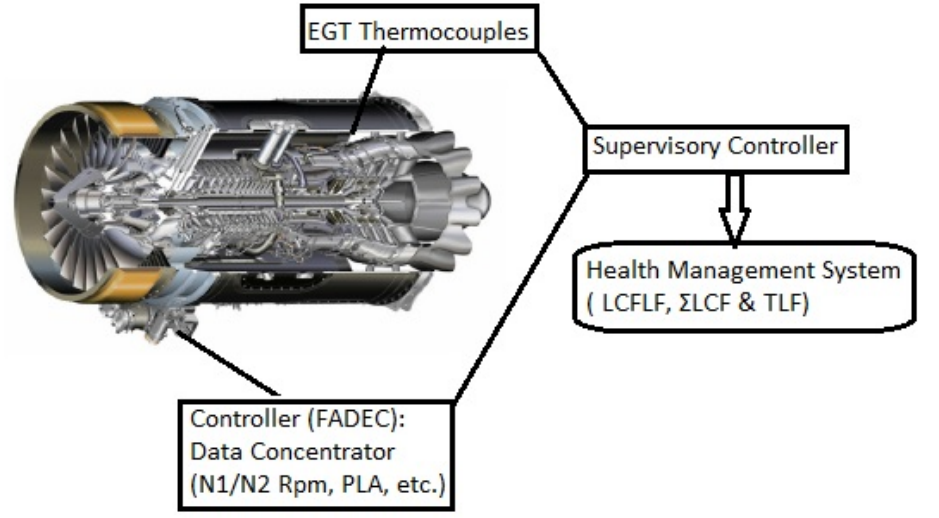
Figure 6. Proposed DEC architecture for EMB 135/145. The picture of Engine, adapted from Aeromax Homepage